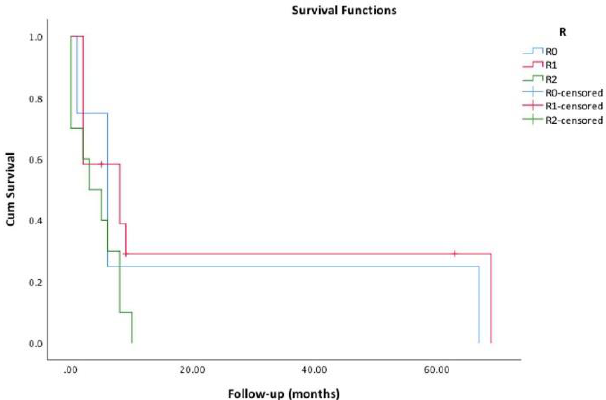
Figure 2. Survival functions regarding surgical margins (R0 vs. R1 vs. R2).